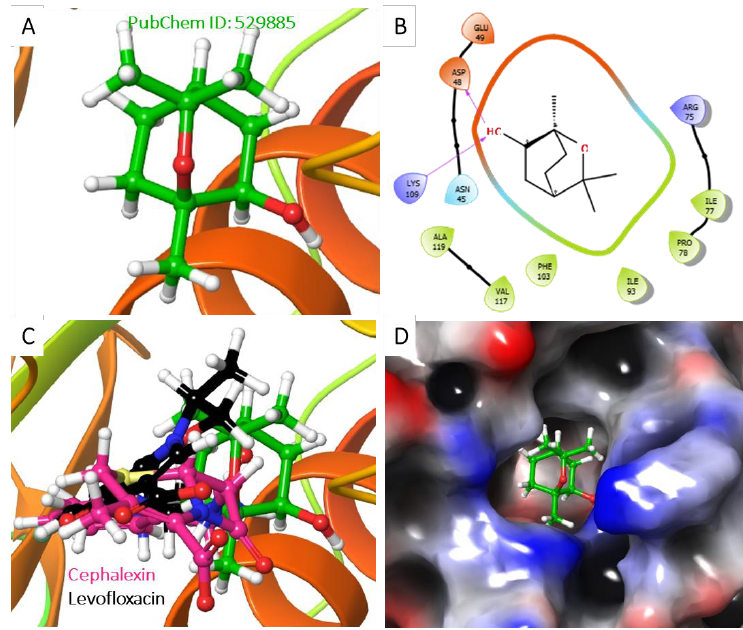
Figure 8. Analysis of the best-predicted docking pose of 529885. ( A ) 3D representation of the 1KIJ–cephalexin complex. ( B ) 2D interaction diagram of the 1KIJ–cephalexin complex. ( C ) 3D representation of the 1KIJ–cephalexin complex, as superimposed with the standard levofloxacin (green backbone). ( D ) Hydrophobic surface representation of 1KIJ when complexed with cephalexin as shown in Figure 8.